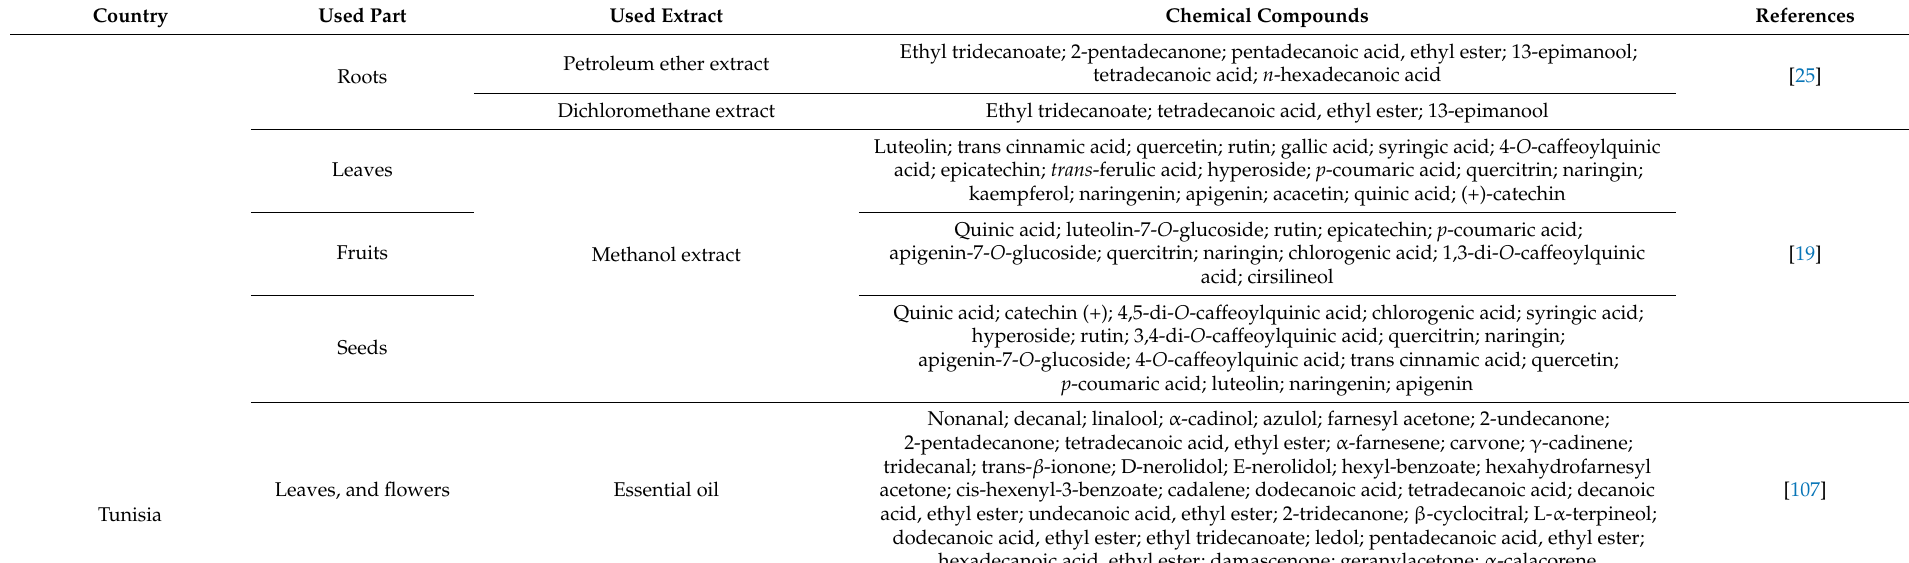
Table 2. Phytoconstituents of the Z. lotus